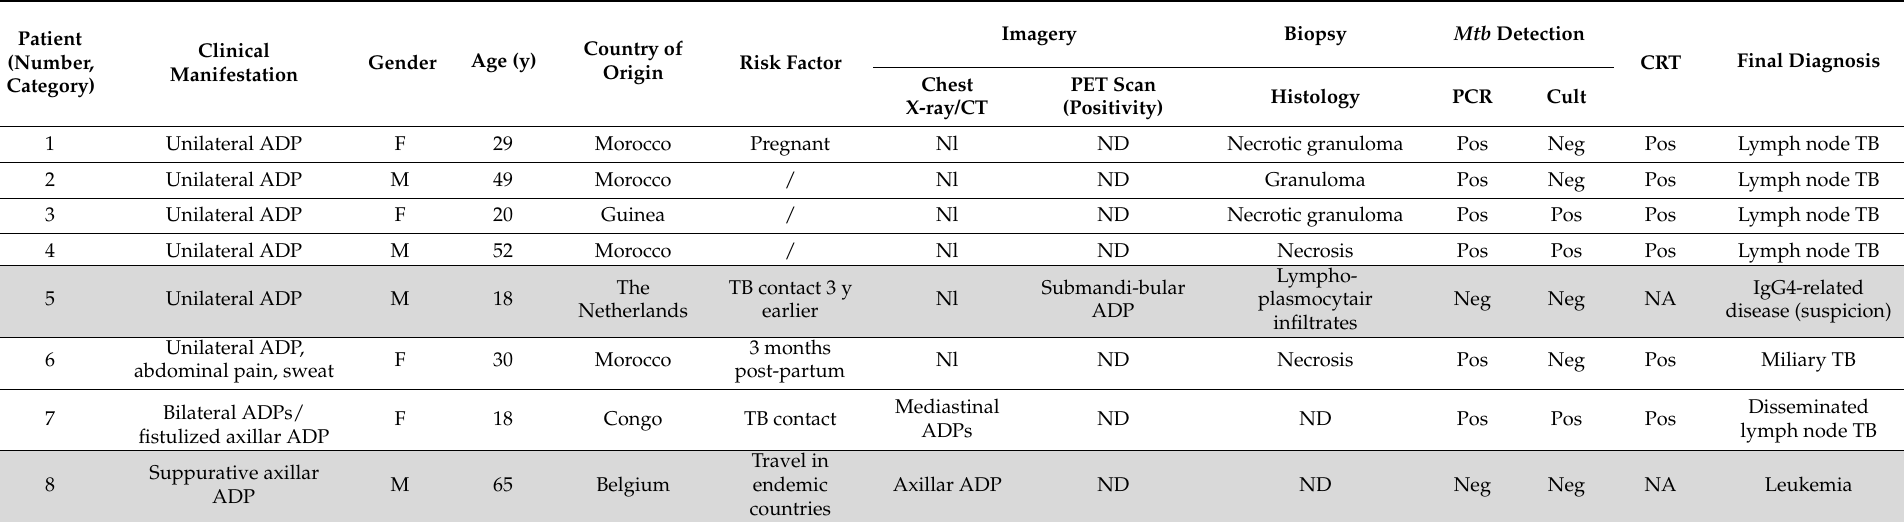
Table 1. Characteristics of patients included in group 1 with cervical/axillar